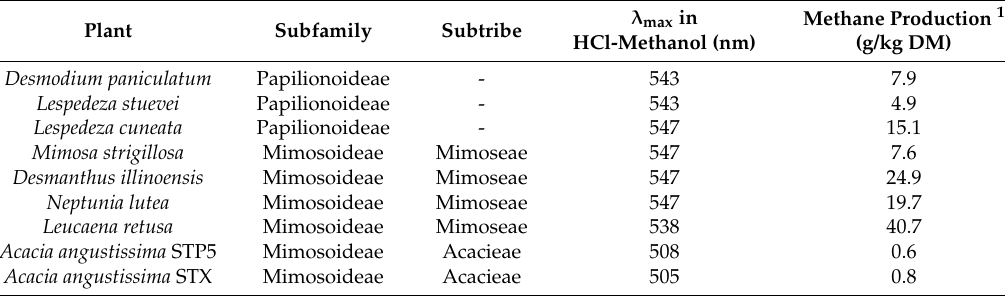
Table 1. Dry land Texas legumes ( Fabaceae ) used in this